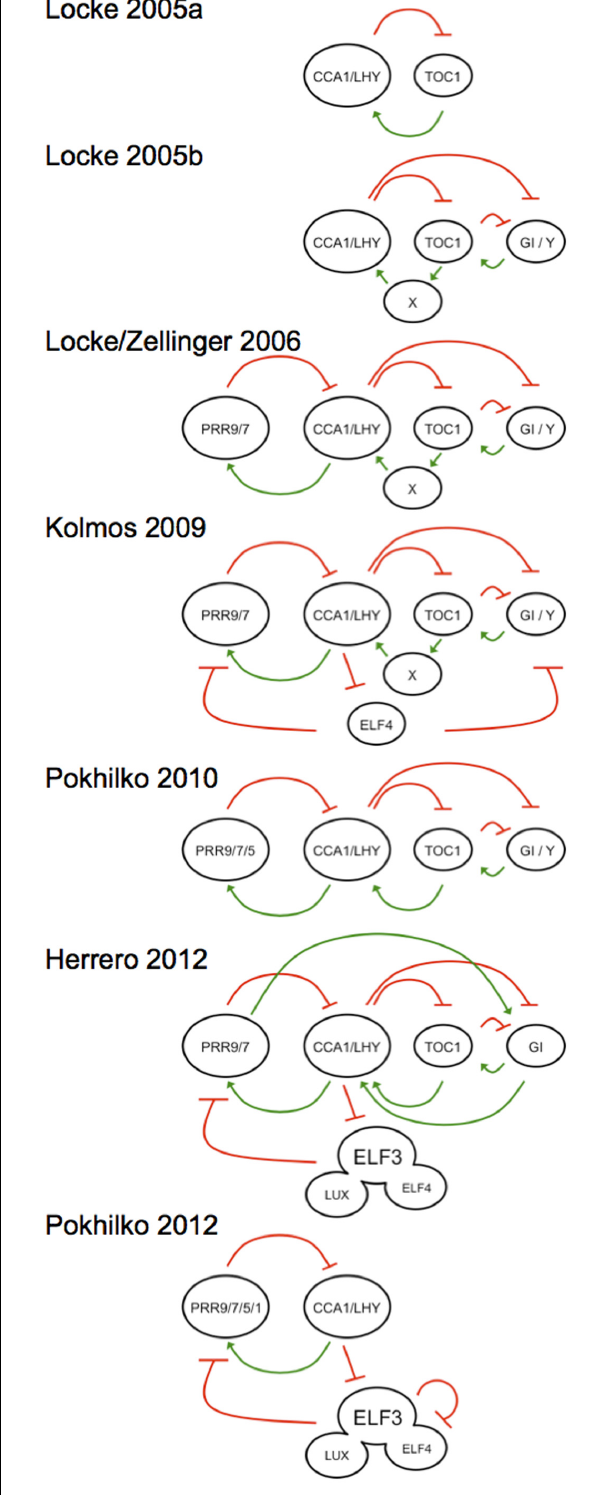
FIGURE 1 | Graphical outline of the mathematical A. thaliana clock models in historical order, showing the development from a simple positive–negative feedback model (Locke etal., 2005a) toward more